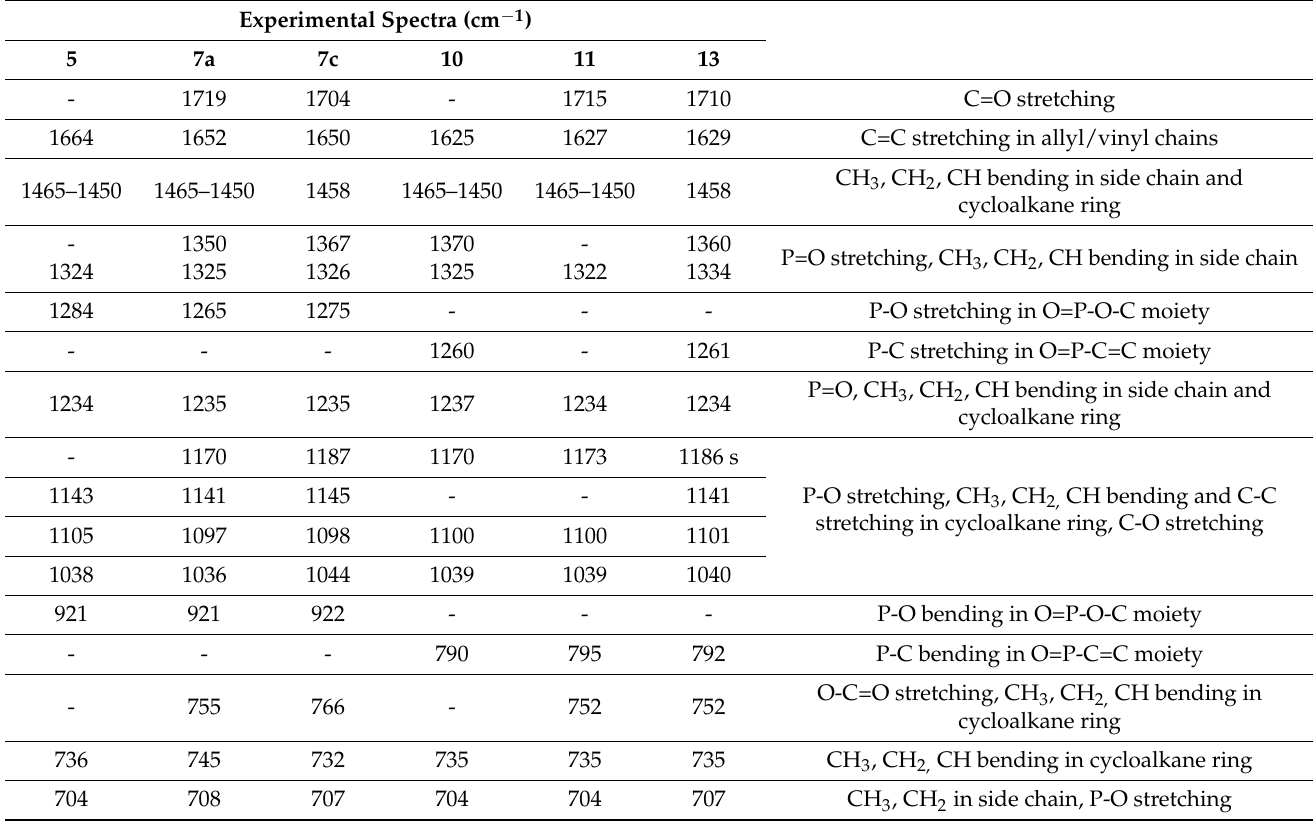
Table 1. Experimental band frequencies and assignments of Raman spectra for compounds 5 , 7a , 7c , 10 , 11 , and 13 . Experimental Spectra (cm −1 )